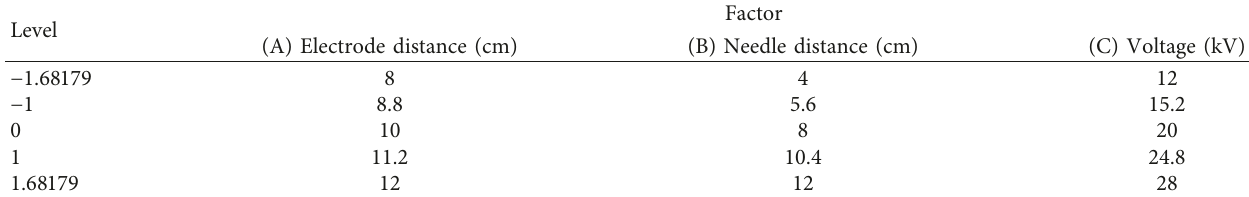
Table 1: Level table of orthogonal test factor for high-voltage electric field.